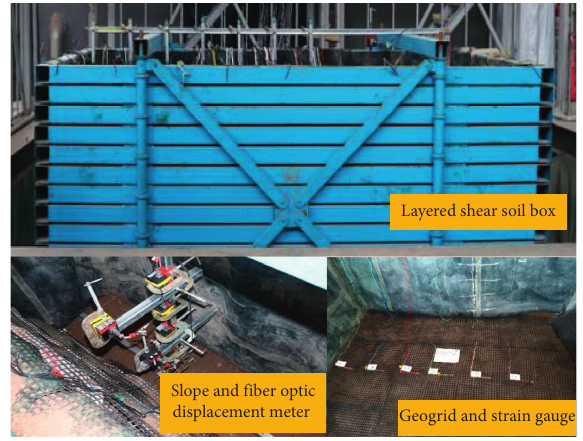
Figure 1: Image of horizontal layered shear box. Table 1: Relevant technical indicators of the shaking table. Characteristic